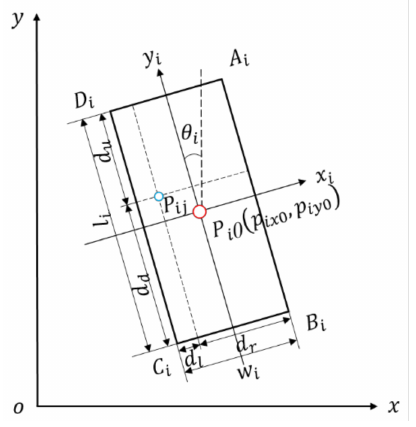
Figure 16. Illustration of the bounding box centroid evaluation index. The convex hull point set H = { p i 1 , p i 2 , · · · , p in } contains n convex hull points for the i obstacle vehicle in each frame of point cloud data H = { p i 1 , p i 2 , · · · , p in } . Firstly, it needs (cid:113) (cid:113) d jr . Secondly, the geometric mean d ju d jd and d jl d jr of each point are calculate.